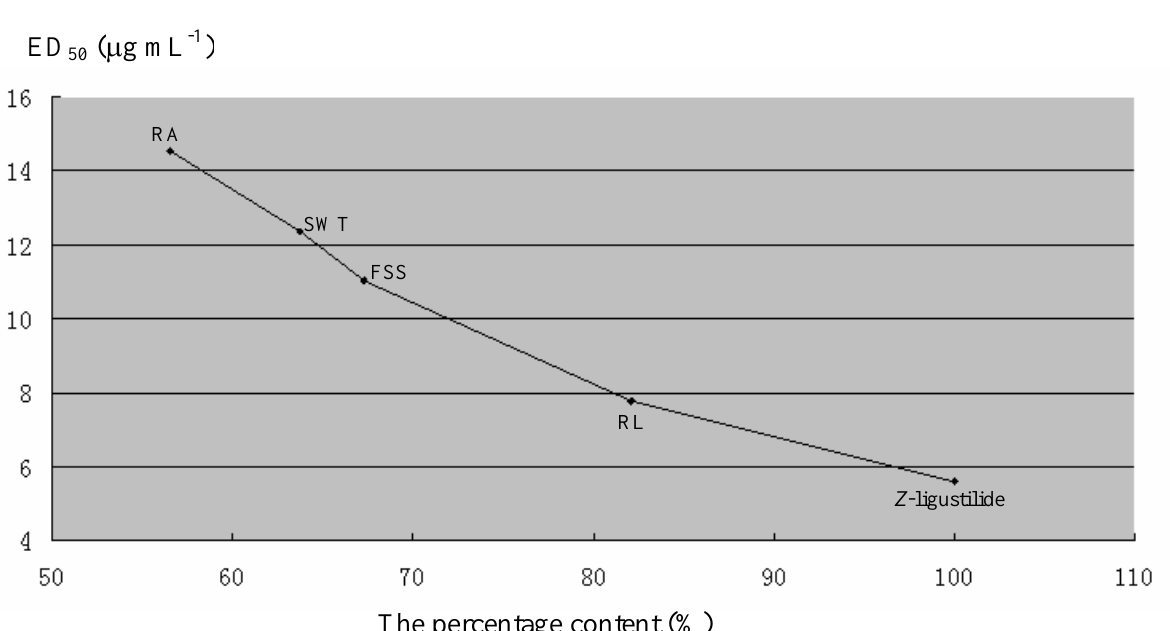
Figure 3. The percentage content (%) of total phthalides in － essential oil effects on uterine contraction in vitro